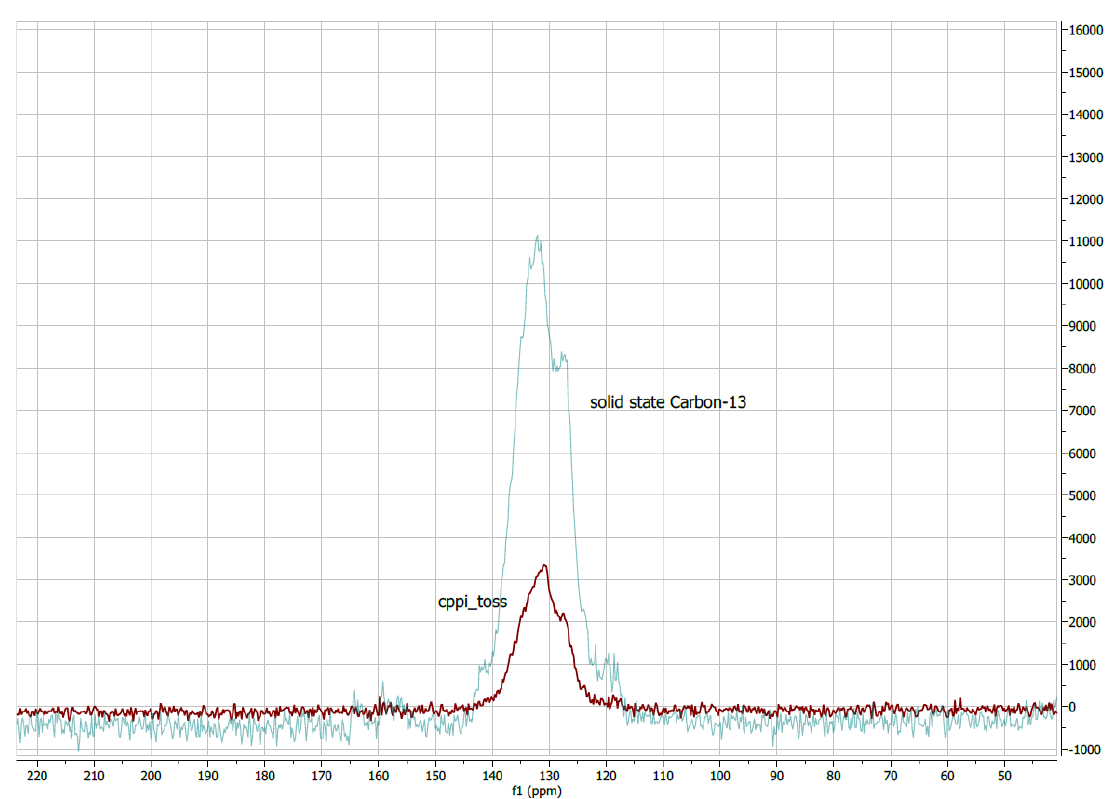
Figure 5. A region (50–220 ppm) of the solid-state 13 C NMR and CPTOSS spectrum of compound 2 .